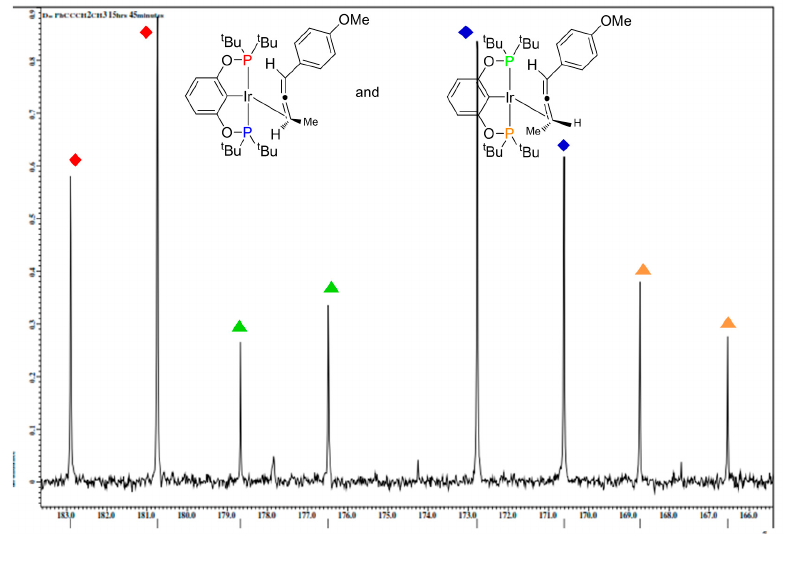
Figure 3 . Cont . Figure 3.